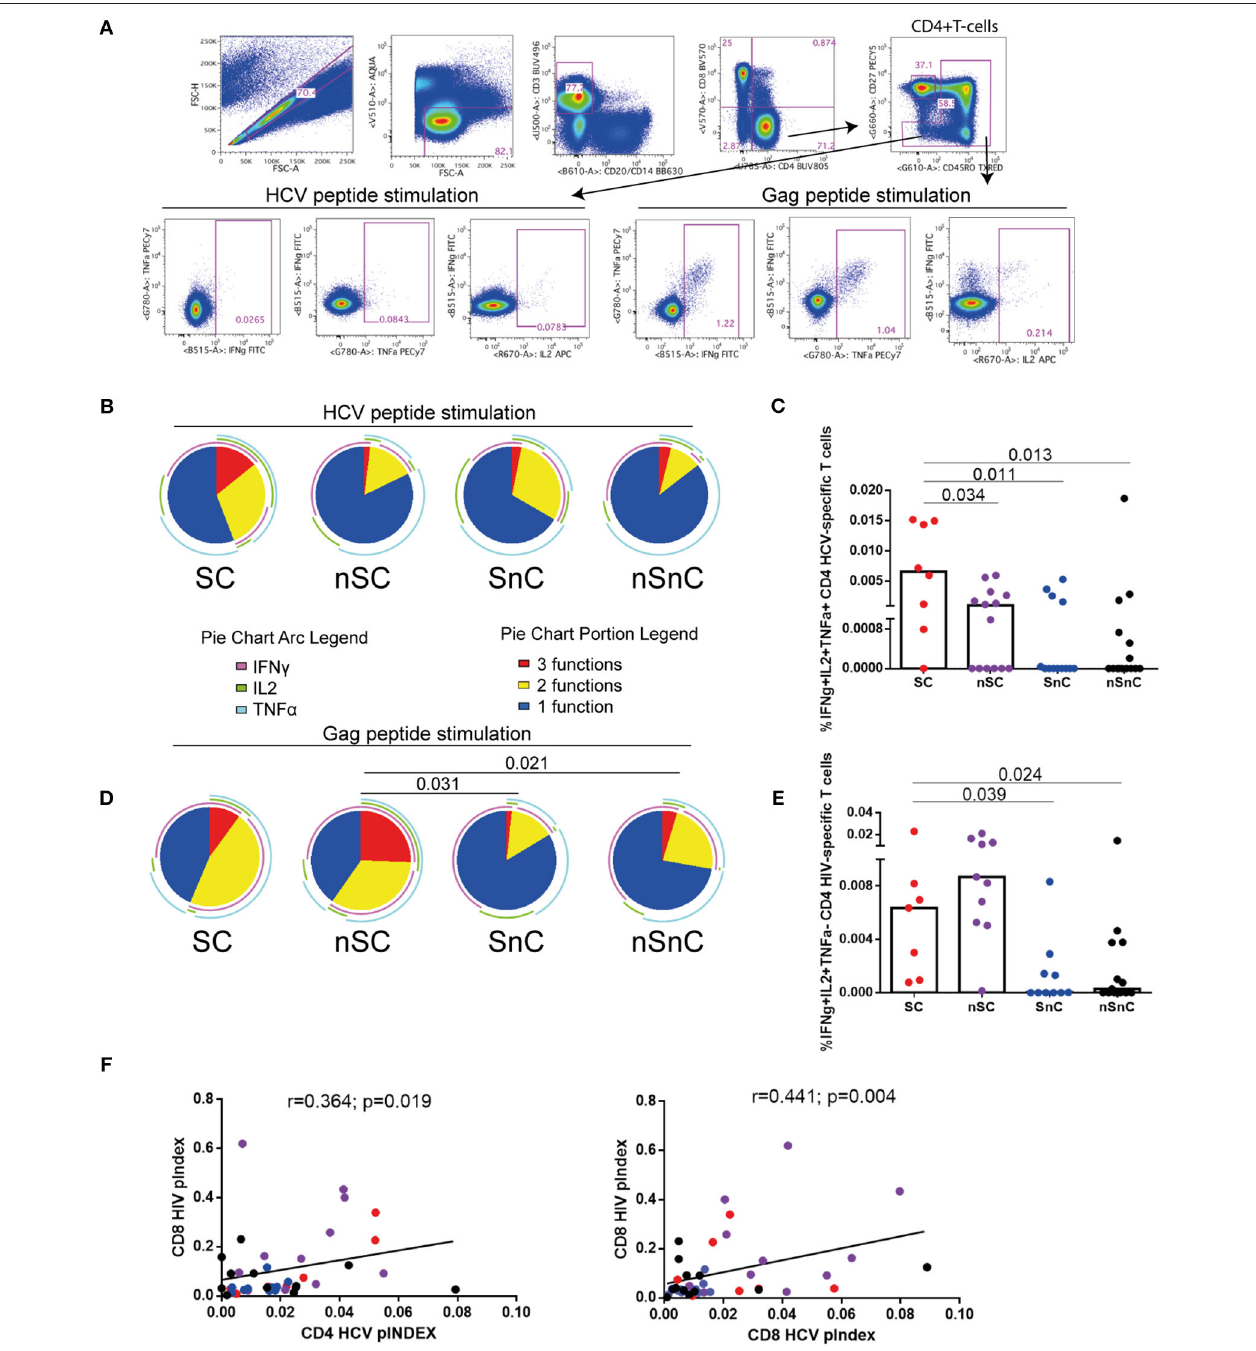
FIGURE 1 | HCV- and HIV- CD4 specific T-cells. (A) gating stratregy. (B) HCV-specific CD4 T-cell polyfunctionality pie charts. Permutation test, following the Spice version 5.2 software was used to assess diferencies between pie charts. (C) Cytokines combinations from HCV-specific CD4 T-cell. Mann–Whitney U -tests was used to assess diferencies between groups. (D) HIV-specific CD4 T-cell polyfunctionality pie charts. Permutation test, following the Spice version 5.2 software was used to assess diferencies between pie charts. (E) Cytokines combinations from HIV-specific CD4 T-cell. Mann–Whitney U -tests was used to assess diferencies between groups. (F) Spearman correlations between CD4 and CD8 HCV-specific T-cells polyfunctionality index and CD8 HIV-specific T-cells polyfunctionality index. SC: supercontrollers, HCV spontaneous clearers and HIV-elite controllers; nSC: non-spontaneously HCV clearers HIV-elite controllers; SnC: HCV spontaneous clearers non-HIV-elite controllers; nSnC: non-spontaneously HCV clearers non-HIV-elite controllers.